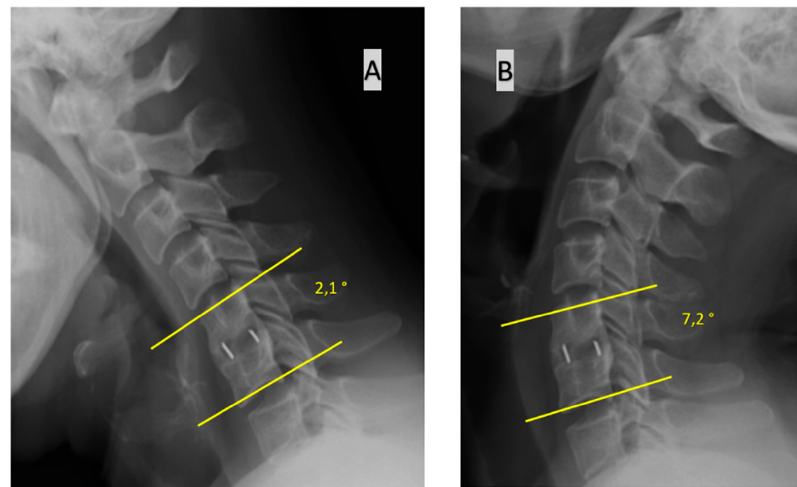
Figure 2. Assessment of bone fusion based on the change of Cobb’s angle of the operated motion segment in flexion ( A ) vs. in extension ( B ). Lower Cobb’s angles are noted in flexion.